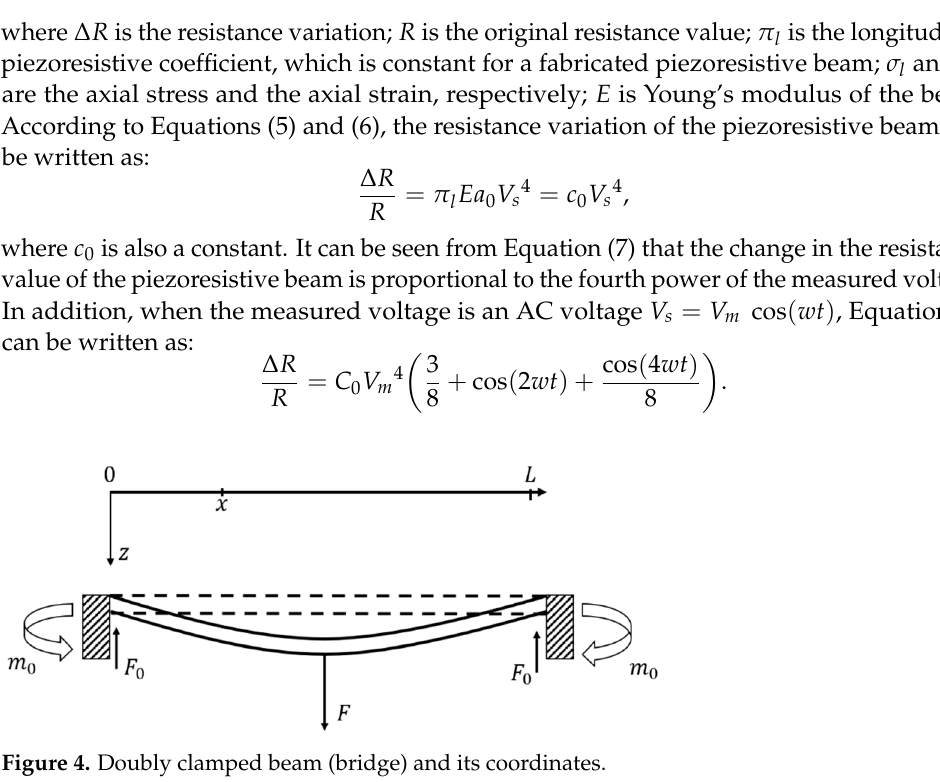
Figure 5. The simulation results between the axial strain of the piezoresistive beam 𝜀 (cid:3051) and the amplitude of the measured voltage 𝑉 (cid:3040) . It can be seen from Figure 5 that the axial strain of the piezoresistive beam was proportional to the fourth power of the measured voltage. In addition, according to Equation (6), the change in the resistance value of the piezoresistive beam is linear with the axial strain of the piezoresistive beam; therefore, the change in the resistance value of the piezoresistive beam was proportional to the fourth power of the measured voltage, which was in good agreement with the theoretical model. To the design of the parameters of the sensor structure, according to Equations (2)– (4) and (7), the vibrating diaphragm area 𝐴 (the side length of the vibrating diaphragm area 𝐿 (cid:3031) ) and the length of the piezoresistive beam 𝐿 have the greatest effects on the re- sistance variation of the piezoresistive beam. Therefore, Figure 6 shows the finite element simulation results, which is the relationship between the axial strain of the piezoresistive beam and the parameters of the sensor structure.